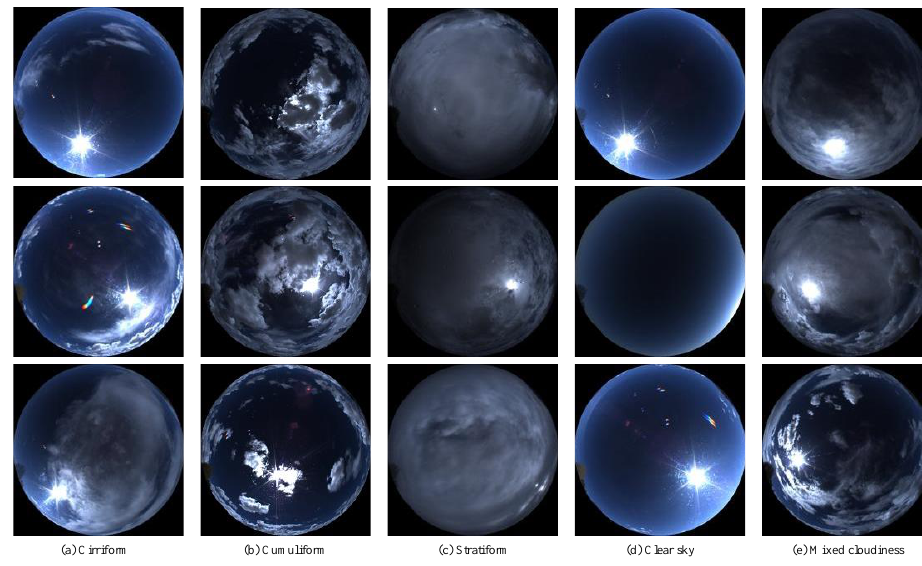
Figure 3. Classic all-sky images of the five sky condition classes. Table 1. Sky condition classes proposed in this